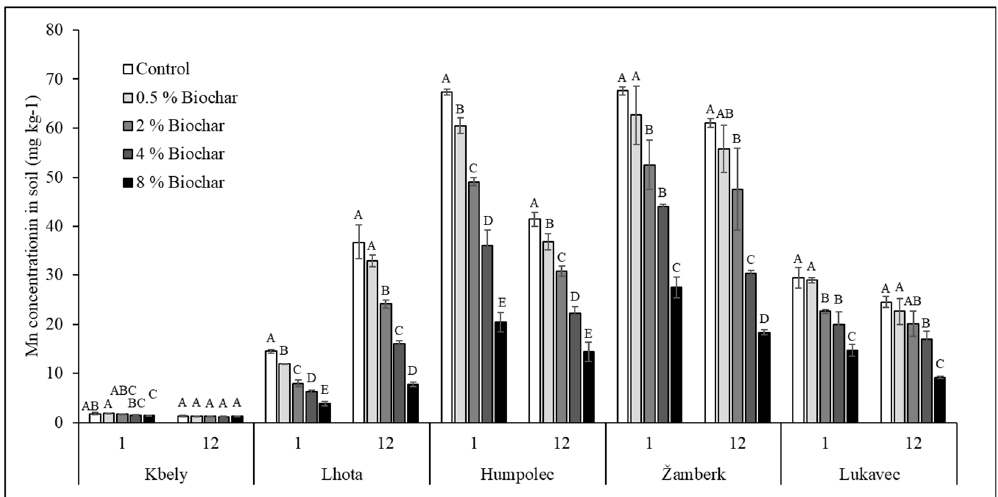
Figure 4. Effect of biochar addition on soil-available content of Mn (mg kg − 1 ). On the horizontal axis,